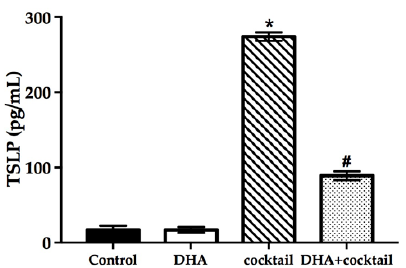
Figure 5. E ff ect of DHA on the TSLP secretion of RHE models with or without 20 µ g / mL LPS plus 10 µ g / mL poly I: C. The changes of TSLP were assessed using ELISA. Data are expressed as mean ± standard deviation (SD). * Compared with the normal control, p < 0.05; # compared with the inflammatory group, p < 0.05. TSLP, thymic stromal lymphopoietin.